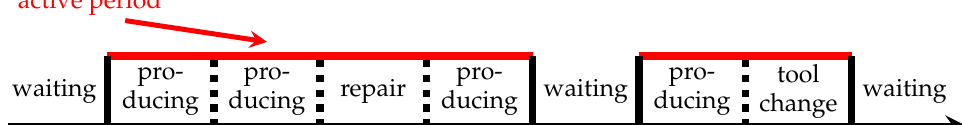
Figure 3. An example of active periods in a schematic process timeline.